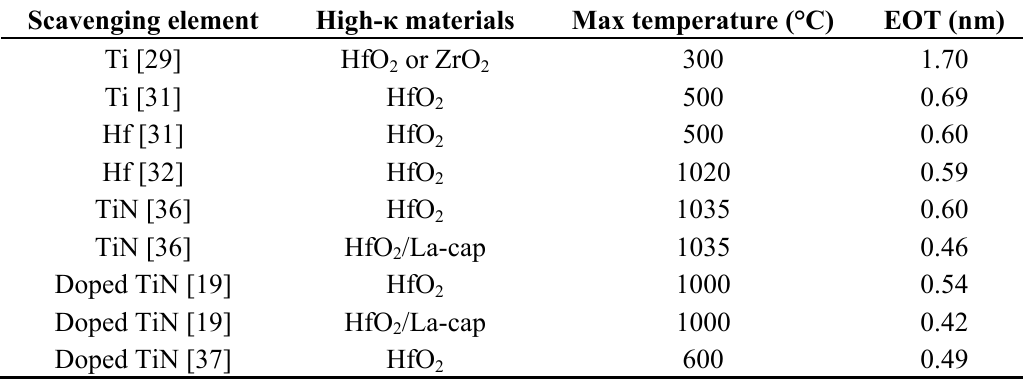
Table 2. Summary of IL scavenging processes in the